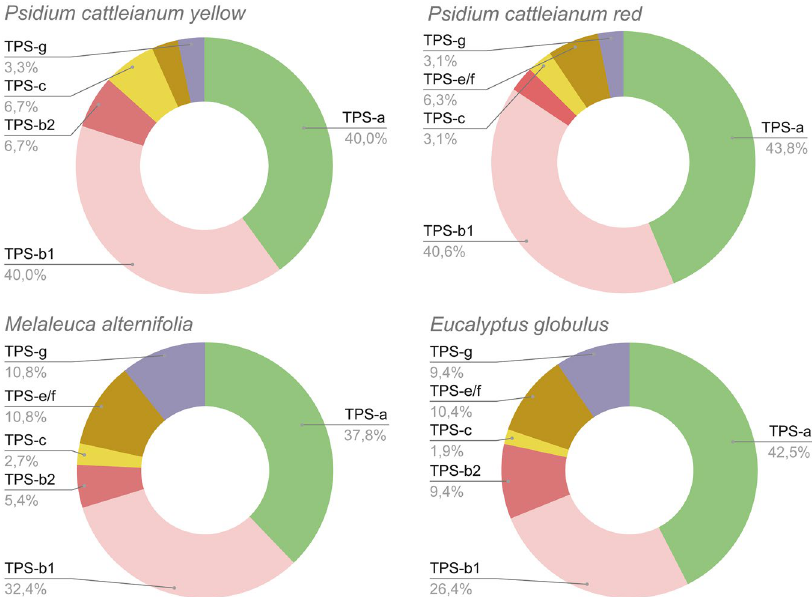
Figure 3. Proportion of TPS gene subfamilies found in Myrtaceae species. The number of genes in each subfamily relative to the total number of genes indicates the proportion of TPS genes. Psidium cattleyanum had the highest proportion of TPS-b1 genes (~